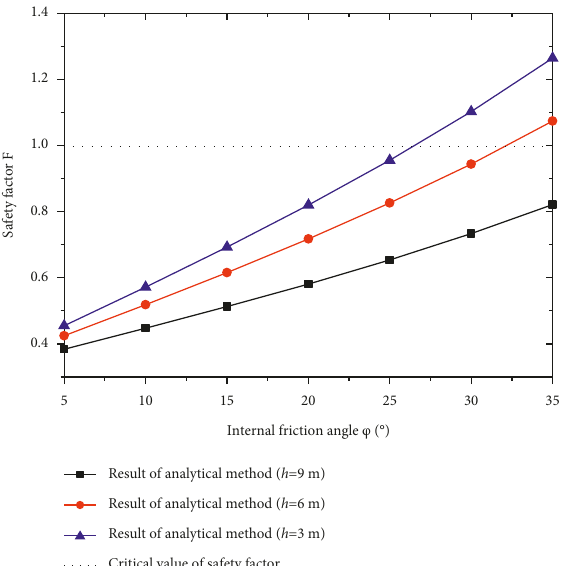
Figure 7: Effect of water level h and internal friction angle φ on safety factor ( k